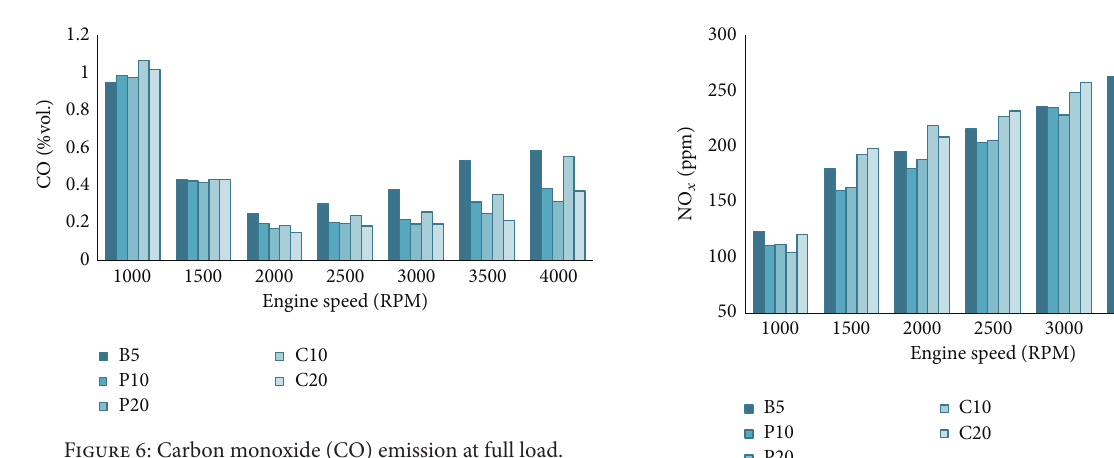
Figure 6: Carbon monoxide (CO) emission at full load.